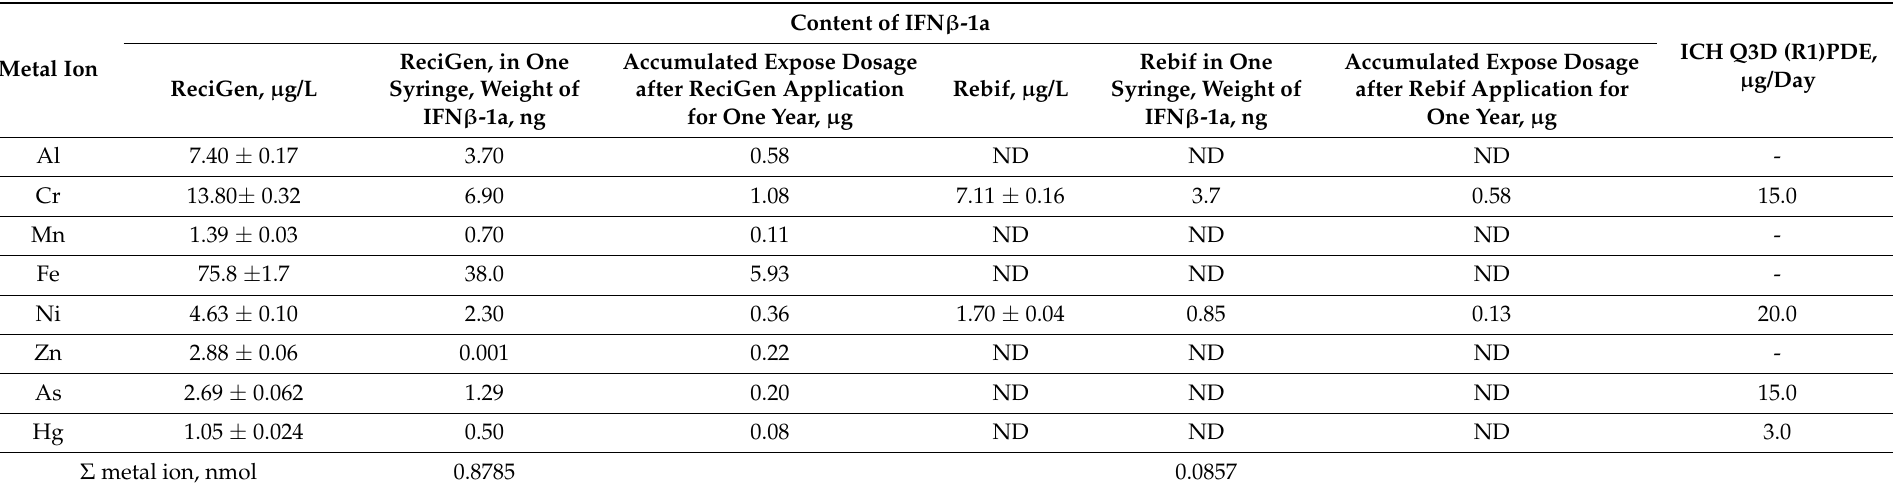
Table 1. Metal ion content in the of IFN β -1a evaluated using ICP MS